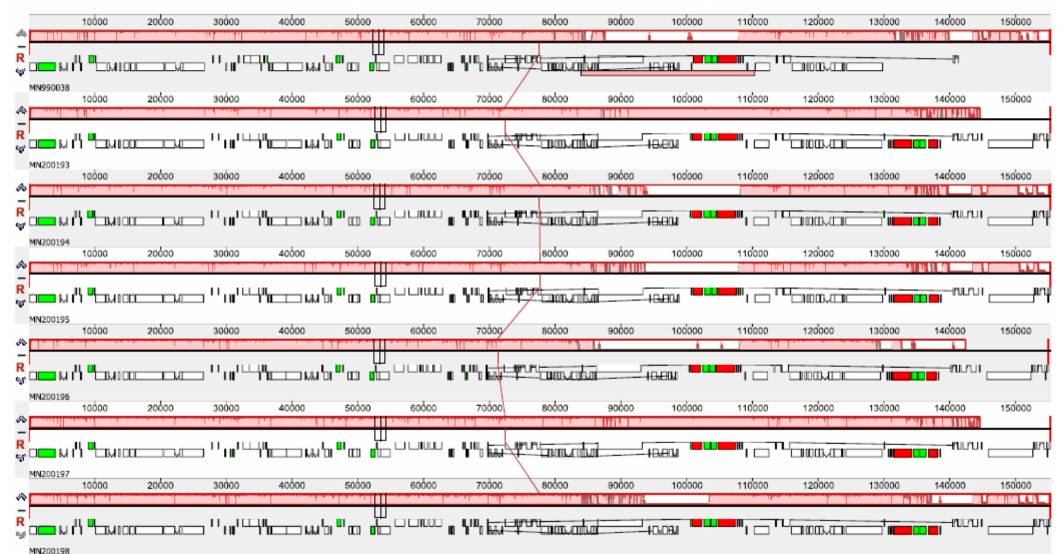
Figure 2. MAUVE alignment of seven Dracaena chloroplast genomes. The D. draco genome is shown at the top as the reference genome. Within each of the alignments, local collinear blocks are represented by blocks of the same colour connected by lines.